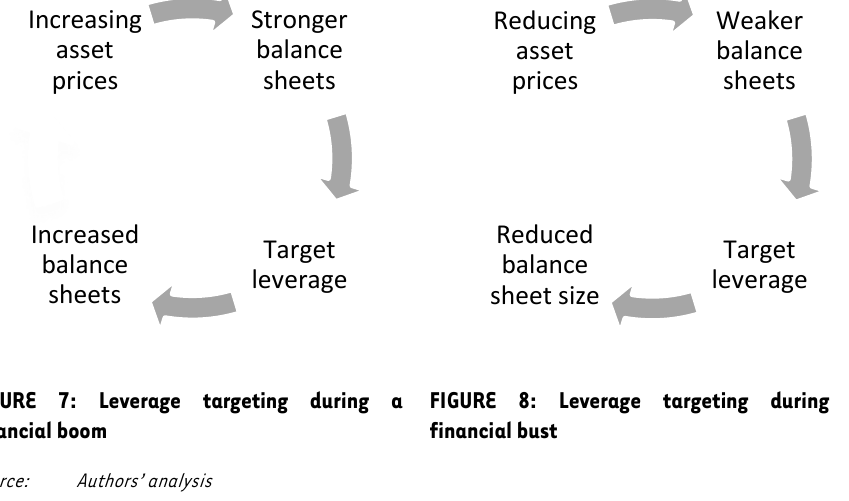
FIGURE 7: Leverage targeting during a financial boom